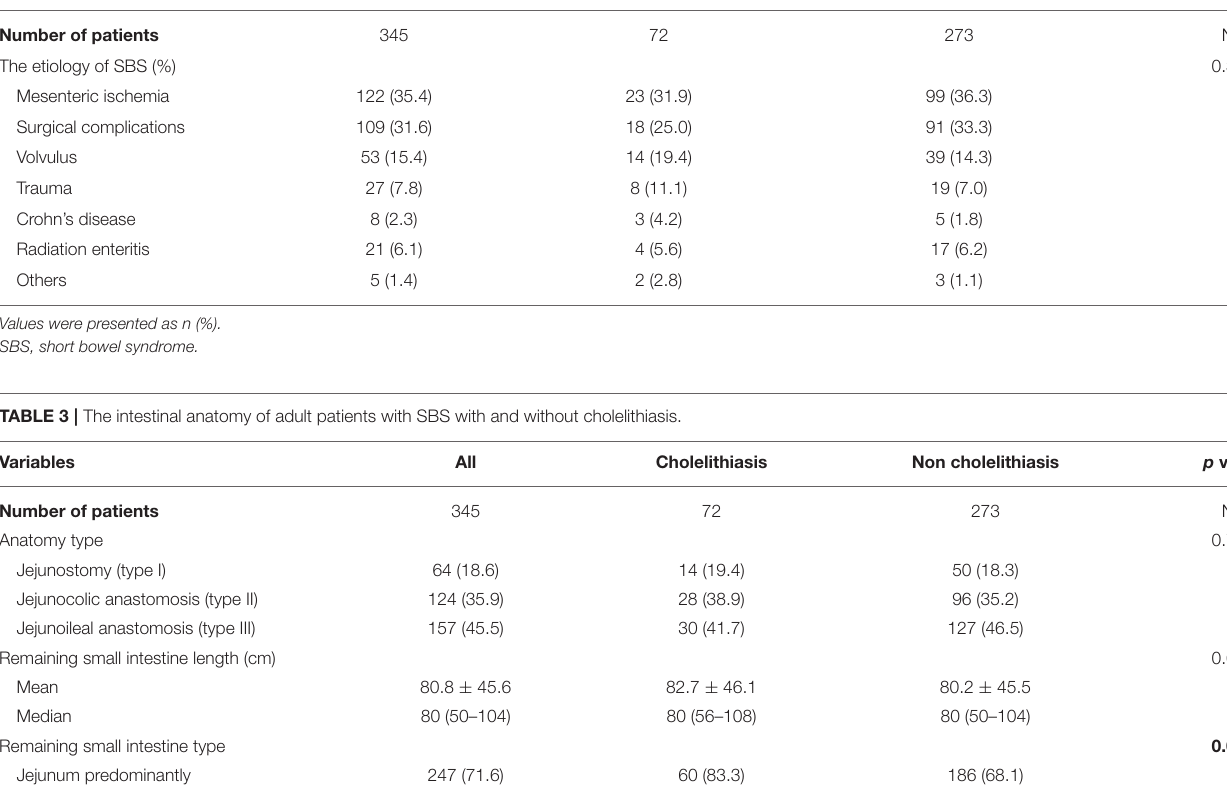
TABLE 2 | The underlying diseases in adult patients with SBS with and without cholelithiasis. Variables All Cholelithiasis Non cholelithiasis p value Number of patients